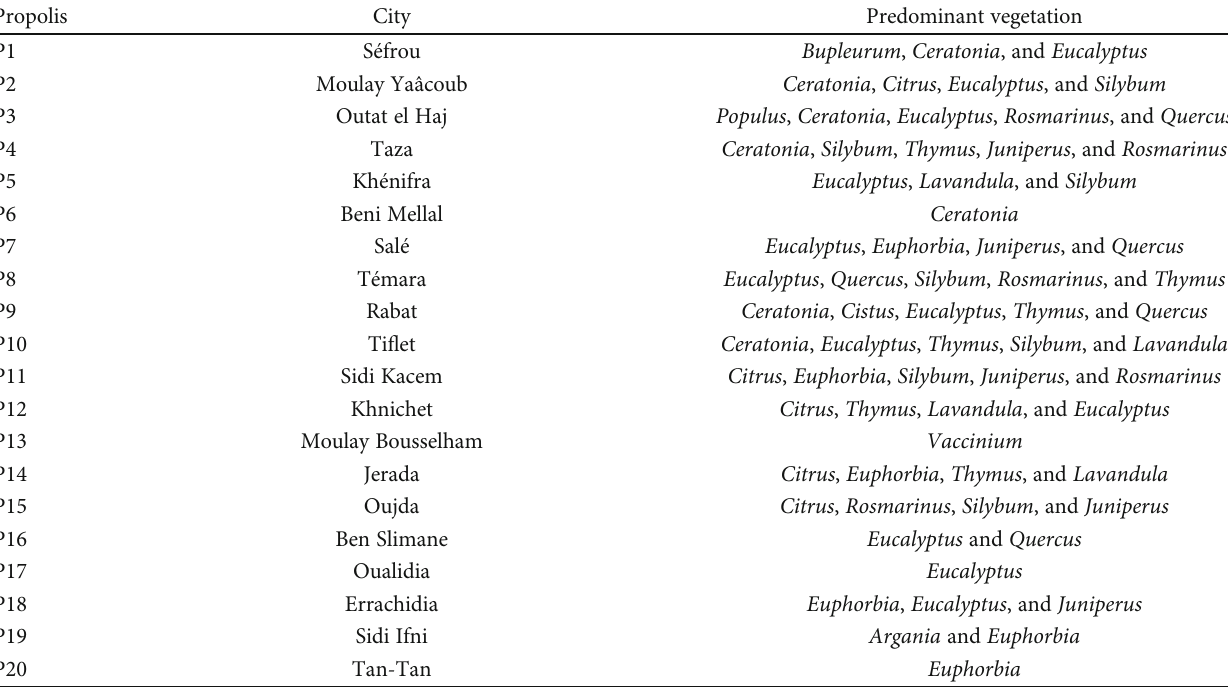
Table 1: Predominant vegetation in the geographical locations of the propolis